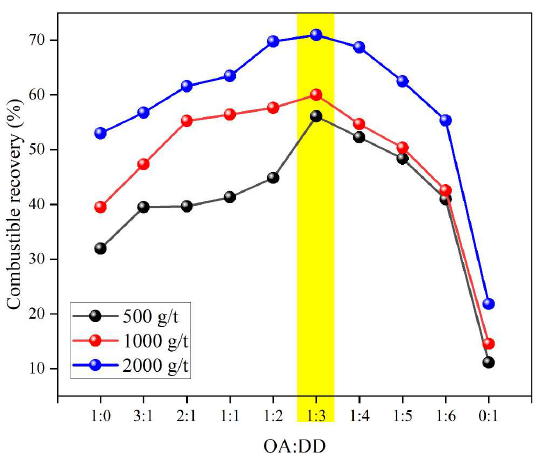
Figure 3. Effect of different compound proportions on combustible recovery. The yellow band indicates the optimal combustible recovery.